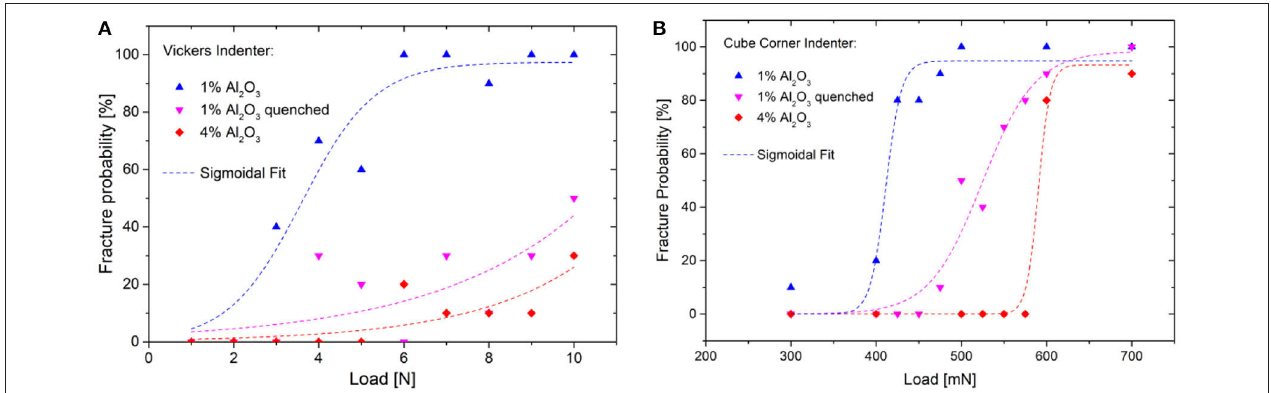
FIGURE 7 | Fracture probability of the NBS2 glass series for (A) Vickers and (B) Cube Corner nanoindentation.